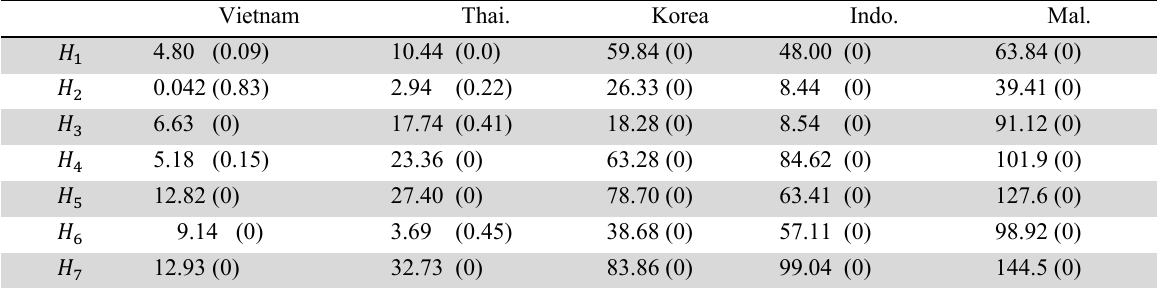
Results of monetary restriction